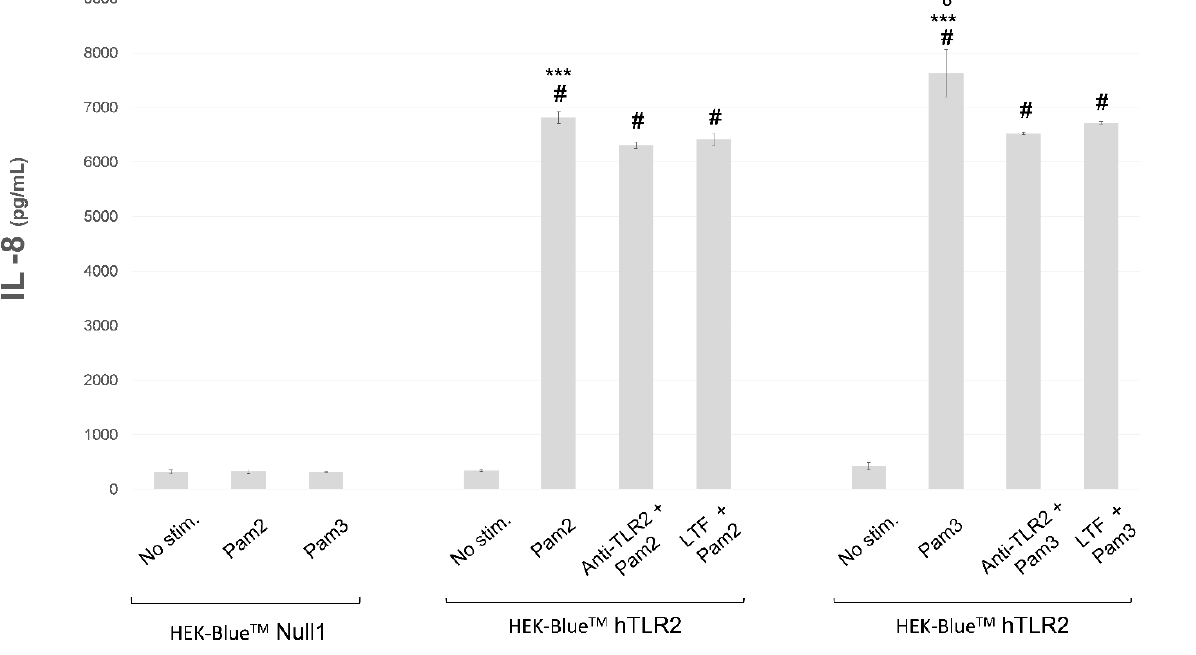
Figure 5. IL-8 concentrations were measured by ELISA in the supernatant of unstimulated, stimulated, neutralized, and immunomodulated HEK-Blue TM cell cultures. Statistical differences with regard to: # p < 0.0001 HEK-Blue TM Null1 and unstimulated HEK-Blue TM hTLR2, *** p < 0.0001 Anti-TLR2 and LTF, δ p < 0.0001 Pam2CSK4 HEK-Blue TM hTLR2. Abbreviations: Anti-TLR2, Anti-hTLR2-IgA; IL-8, interleukin 8; LTF, lactoferrin; No stim., unstimulated; Pam2, Pam2CSK4; Pam3, Pam3CSK4; TLR2, Toll-like receptor 2.